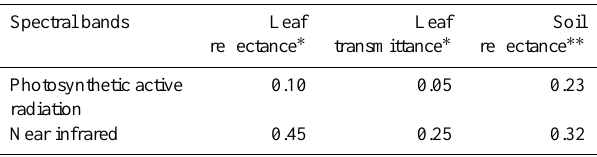
Table 2. The spectral signature of leaf and soil background.